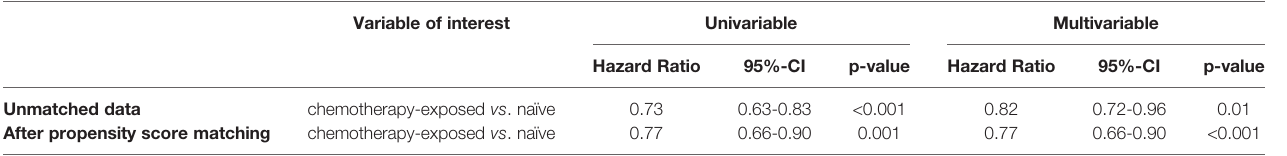
TABLE 2 | Multivariable Cox regression models predicting overall mortality in de novo metastatic prostate cancer patients according to chemotherapy status prior to and after propensity score